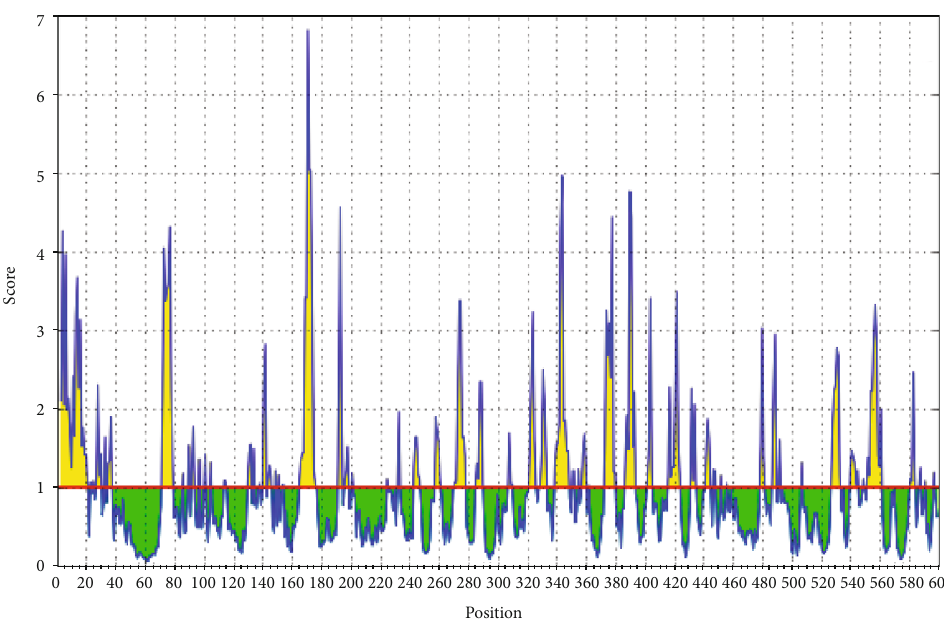
Figure 3: Kolaskar and Tongaonkar antigenicity prediction. Areas above the red line (threshold) are epitopes suggested to be binding to the B cells while the green areas are